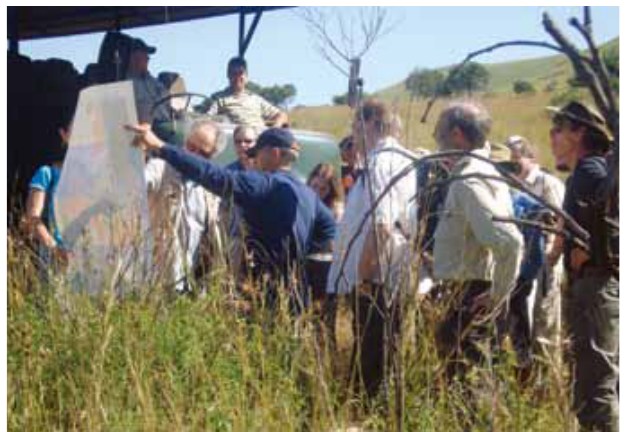
Figure 1. Workshop participants in the field at a potential drill